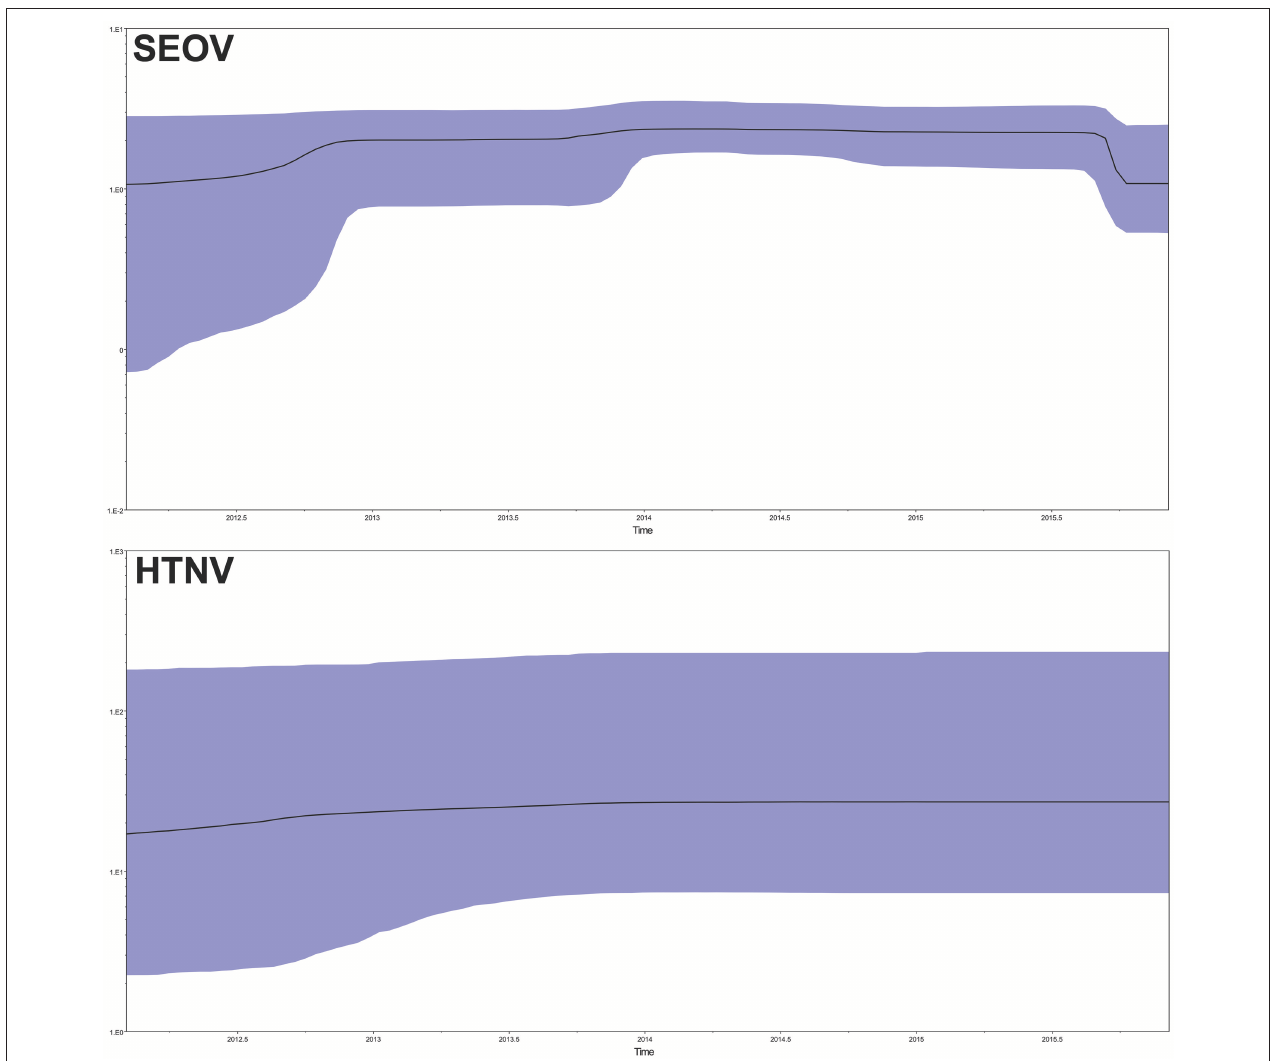
FIGURE 6 | Population dynamics of SEOV and HTNV in Bayesian skyline reconstruction plots. The demographic inference of SEOV and HTNV genetic diversity is depicted using the Bayesian skyline reconstruction plot method. The plot was referred to the concatenated sequences in the order M–S. Solid lines indicate the median estimates, and the purple area displays the 95% highest posterior density (HPD). SEOV, Seoul virus; HTNV, Hantaan